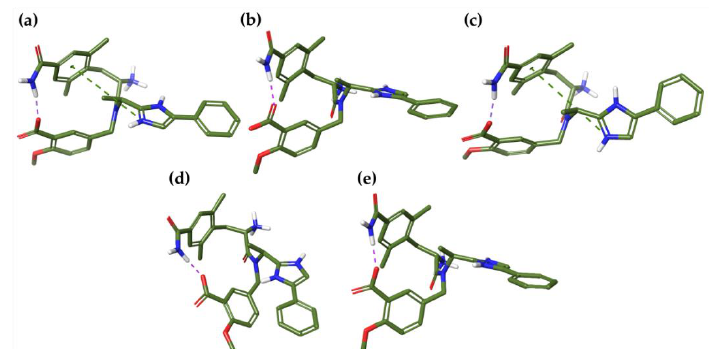
Table 6. % B, RMSd values and intramolecular interactions of the most probable energy minima for E1, obtained after the minimization of all MD frames in both solvents. RMSd values are reported in Å , and they are calculated on the heavy atoms of E1 compared to the global energy minima ( E1- MD1w and E1-MD1o ).